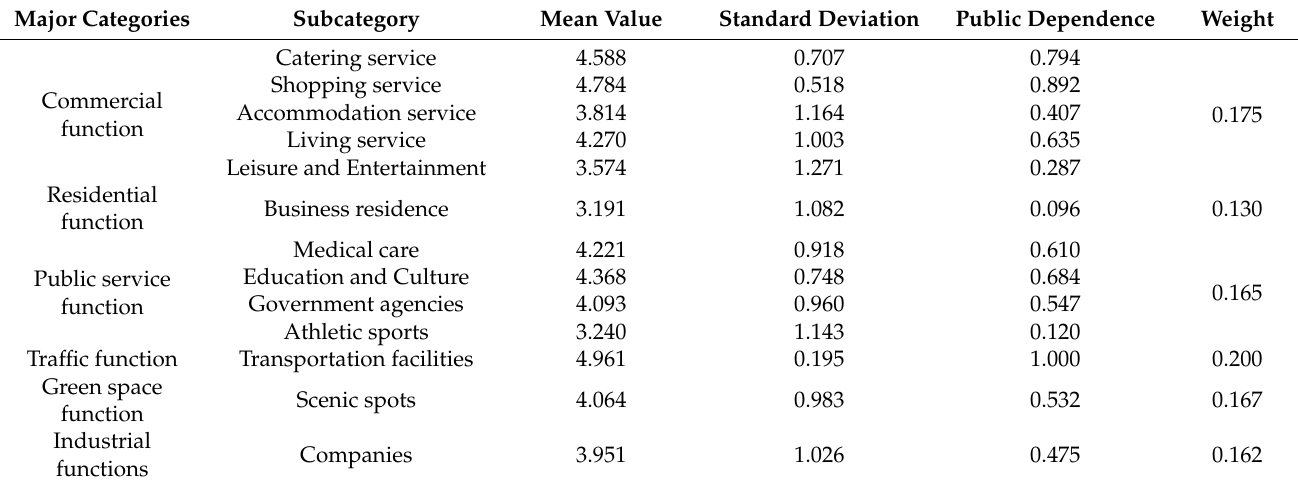
Table 4. Public dependence on various POI data and proportion of each function